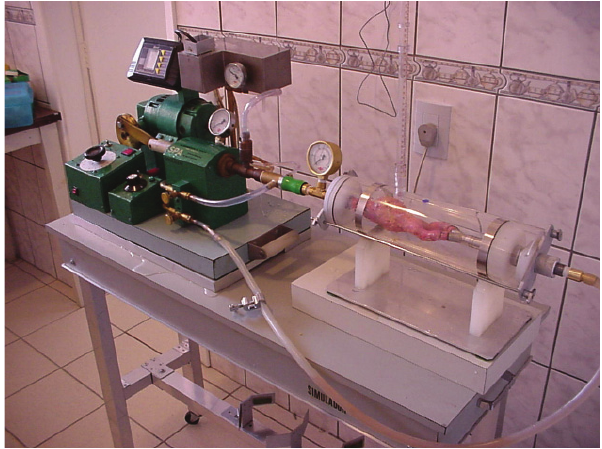
Figure 2 - Aneurysm being submitted to pulsatile